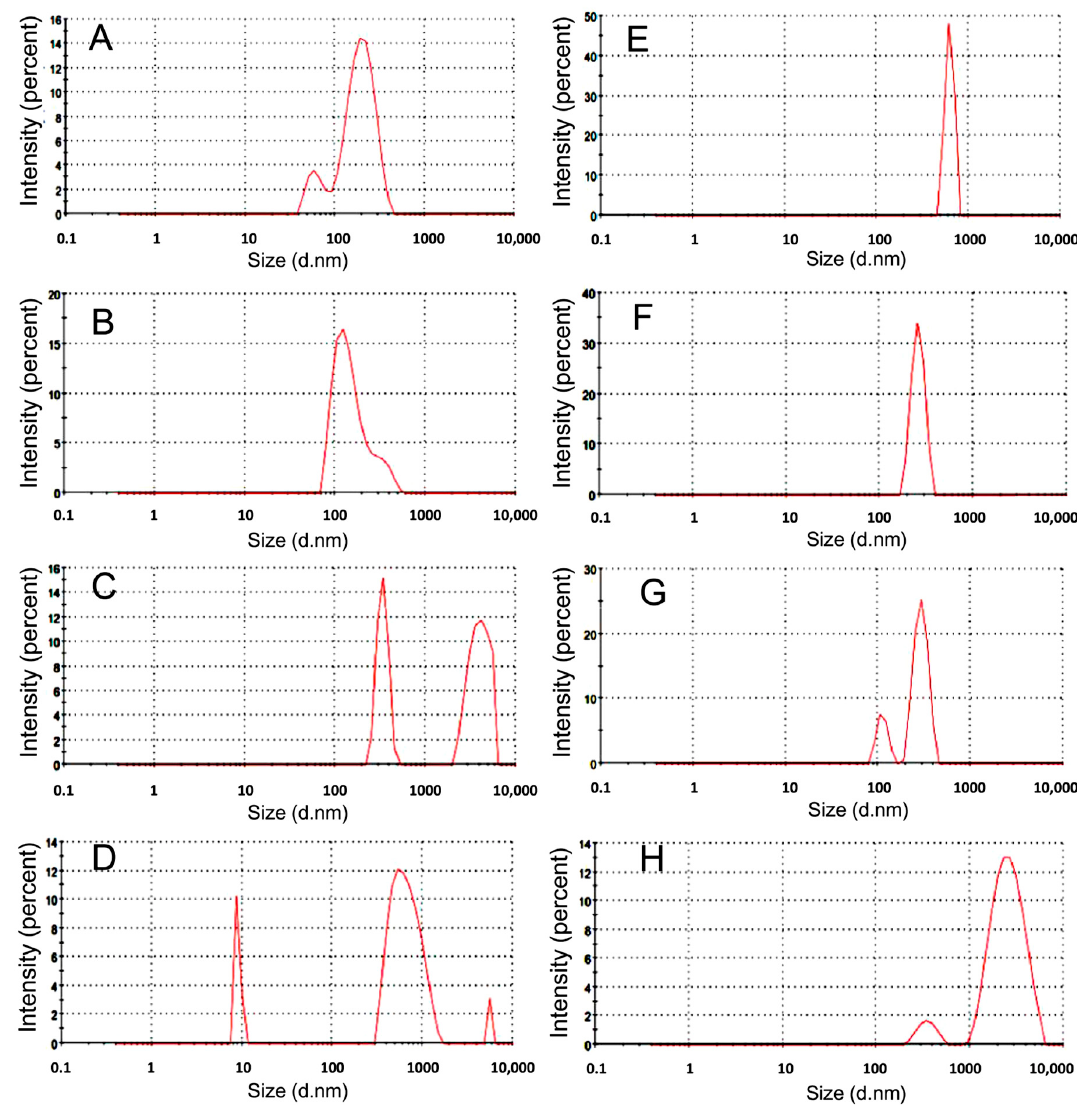
Figure 2. Melanin particle distributions in NaOH solutions at concentrations of 0.1 N ( A ), 0.5 N ( B ), 1 N ( C ), and 3 N ( D ), and in NH 4 OH solutions at concentrations of 0.1 N ( E ), 0.5 N ( F ), 1 N ( G ), and 3 N ( H ); determined by dynamic light scattering, using Zetasizer technology.